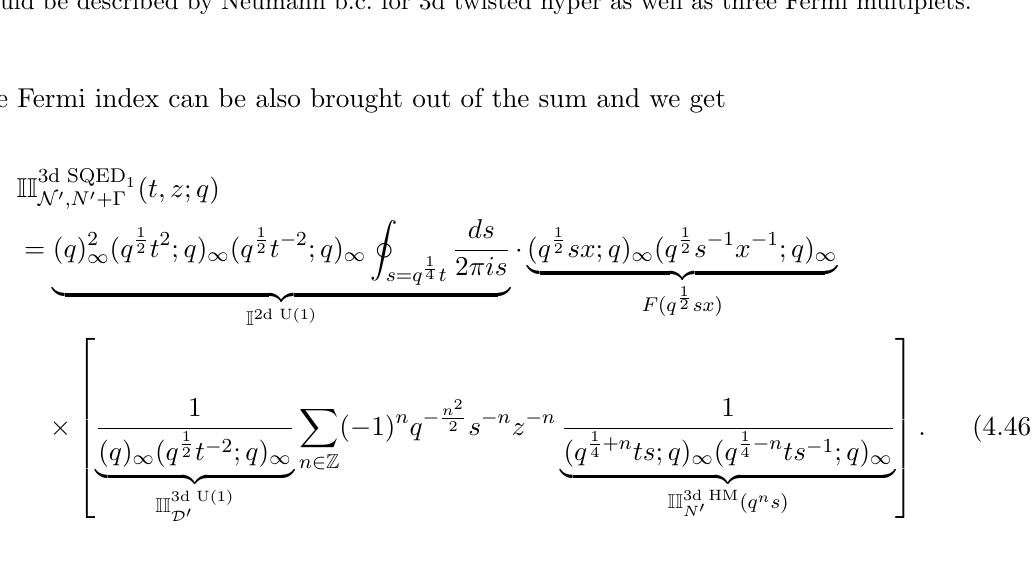
Figure 10 . The brane constructions of the enriched Neumann b.c. involving 2d twisted hyper, 3 and its dual configuration. The dual configuration charged Fermi and a neutral Fermi for SQED 1 would be described by Neumann b.c. for 3d twisted hyper as well as three Fermi